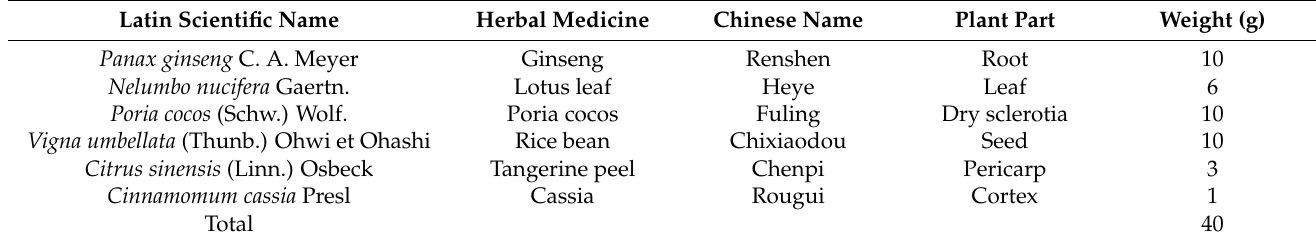
Table 1. The composition and proportions of